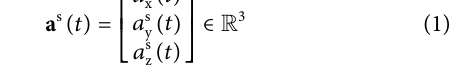
(cid:129) Sensor free linear accelerations in the sensor frames ( R R R R left , head and back ). (cid:129)